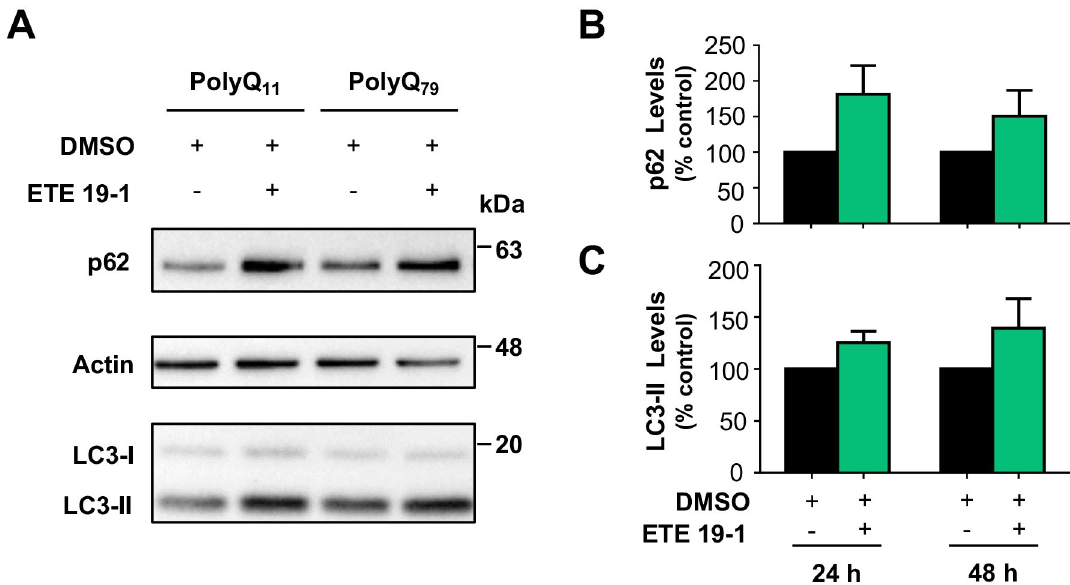
Fig 5. ETE 19–1 modulates the levels of autophagy-related proteins. (A) Modulation of autophagy was assessed by western blot analyzing the levels of p62 and LC3-II. Cells were transfected with polyQ 11 -EGFP, polyQ 79 -EGFP, or mHTT Q85 -GFP expression vectors. 4 h post transfection, cells were treated with ETE 19–1 at 100 µ g/mL. 16 h later, cells were collected, and total protein extracted. p62 and endogenous lipidated LC3-II levels were monitored by western blot using anti-p62 and anti-LC3 antibodies, respectively (upper and lower panel). Actin expression was monitored as loading control (middle panel). (B) p62 and (C) LC3-II levels were quantified and normalized to actin. Results are the mean ± SEM of 3 independent experiments. Statistically significant differences were detected by unpaired t